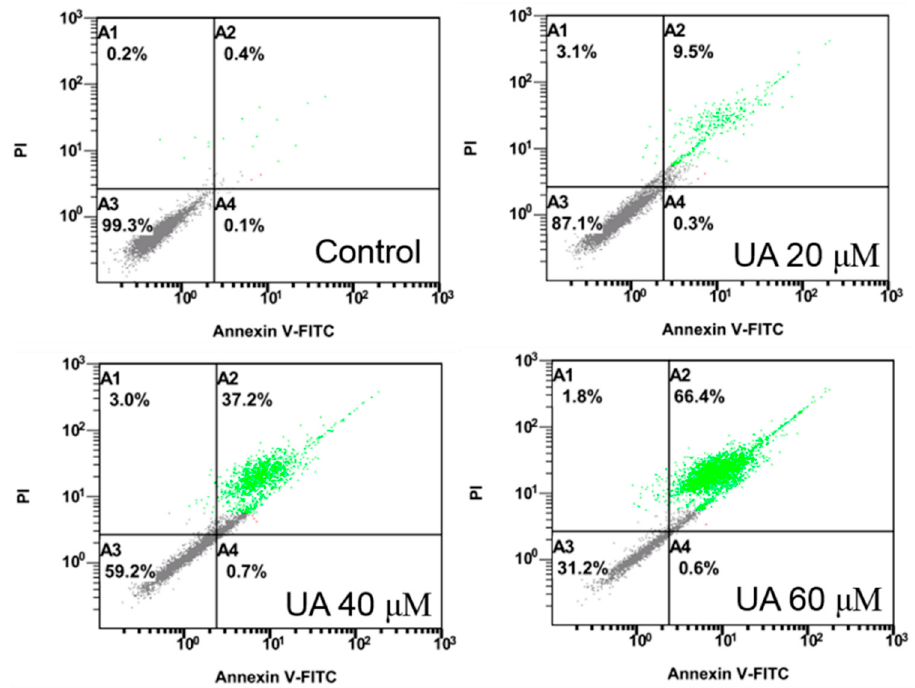
Figure 5. Effect of UA on apoptosis in Huh-7 cells. The cells were exposed to various doses of UA for 24 h. Annexin V/PI staining assays were used to quantify the number of apoptotic cells.